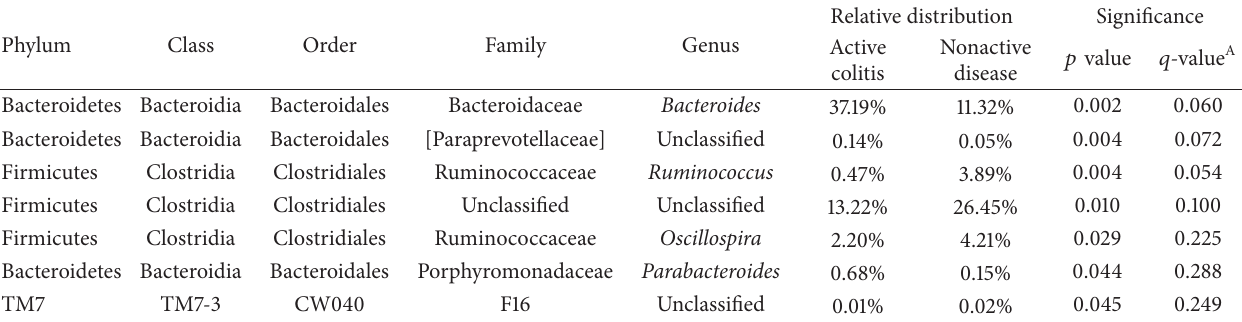
Table 2: Changes in taxa abundance between active colitis (rat-IgG2a and NaCl) and nonactive disease (12p40-mAb and healthy) determined by ANOVA.